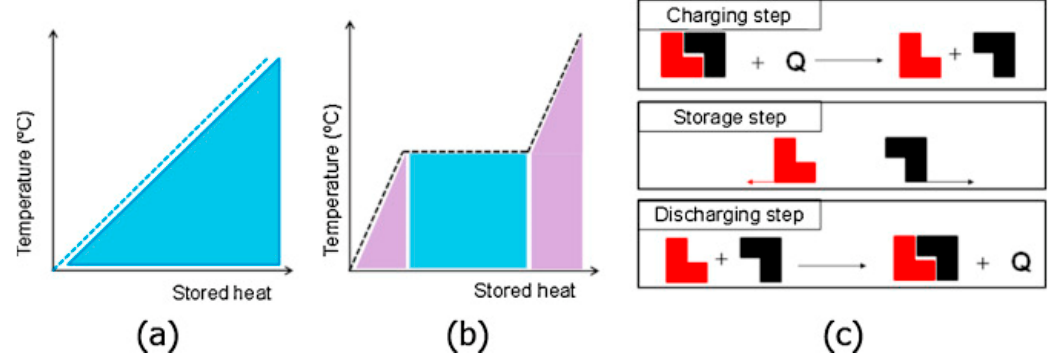
Figure 1. ( a ) Sensible heat, ( b ) latent heat, ( c ) thermo-chemical thermal energy storage systems (Copyright 2015 Gracia and Cabeza) [4].